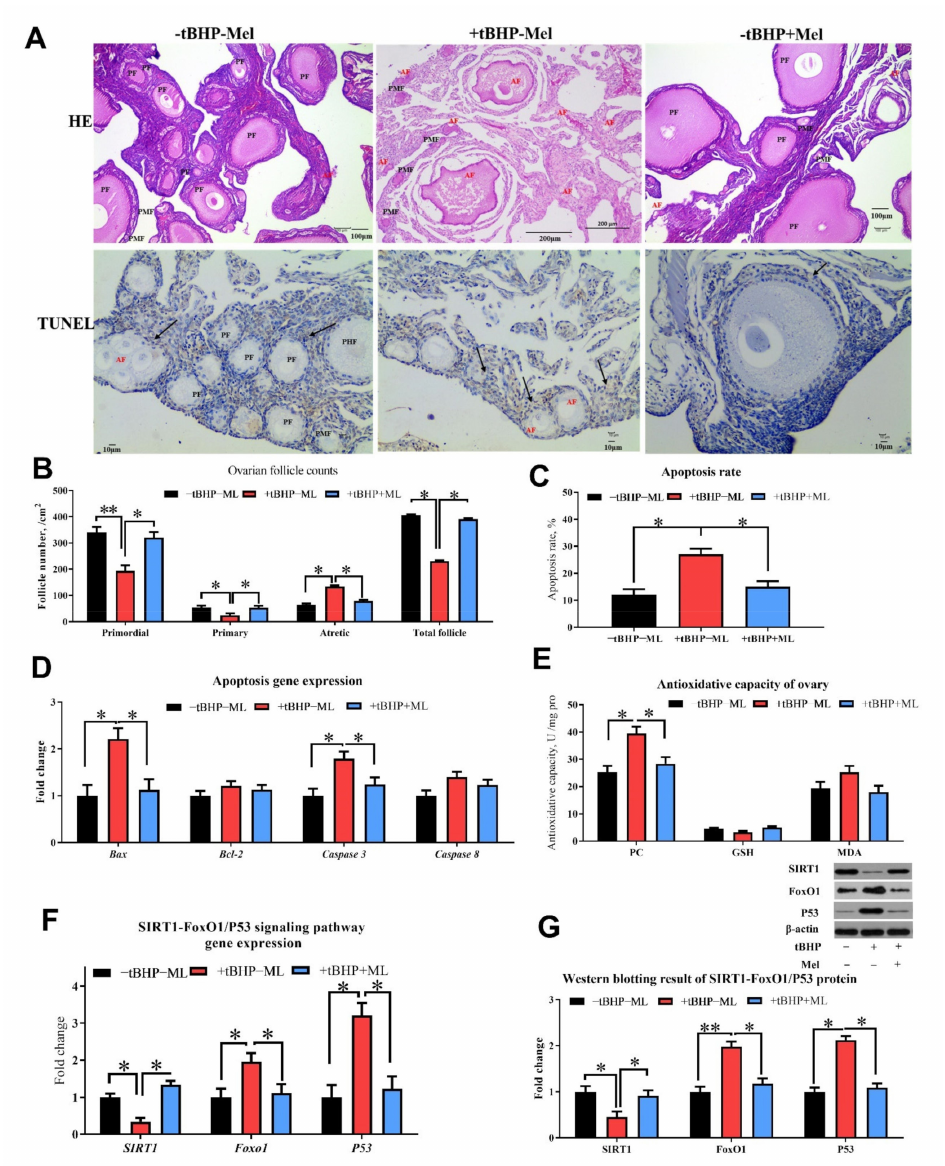
Figure 9. Melatonin ameliorates oxidative stress (tBHP) induced ovarian dysfunction in vitro (Experiment 2). ( A , B ) Ovarian histology and TUNEL analysis of layers after three days of treatment and follicle counts at each developmental stage (PMF = primordial follicle; PF = primary follicle; AF = atretic follicle). TUNEL analysis for cell apoptosis in ovary ( A , C ) showed the TUNEL results with the brown color presents the positive cells. ( D ) RT-PCR analysis for mRNA expression levels related to ovarian apoptosis gene expression. ( E ) Antioxidant capacity analysis for ovary with oxidation product. ( F , G ) the western blotting result of apoptosis associate protein (Bax, Bcl-2, caspase 3 and cleaved-caspase 3). Data are shown as averages and error bars represent SEM ± SEM; statistically significant differences are shown with different letters ( p < 0.05) with one-way ANOVA with Tukey’s test. − tBHP − Mel = 0 tBHP + 0 melatonin, +tBHP − Mel = 50 µ mol/mL tBHP, +tBHP + Mel = 50 µ mol/mL tBHP + 100 ng/mL melatonin, Bcl-2 = B-cell lymphoma-2, SIRT1 = silent information regulator 1, FoxO1 = forkhead box O1, PC = protein carbonyl, GSH = glutathione, MDA = malondialdehyde. Statistical significance was evaluated by t -test, * p < 0.05, ** p <